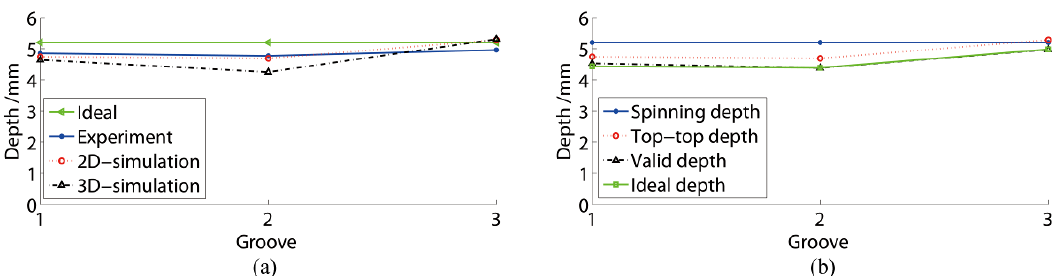
Figure 7. Comparisons of groove depths. ( a ) Comparison between experiments and numerical simulation; ( b ) comparison of three measurement methods.